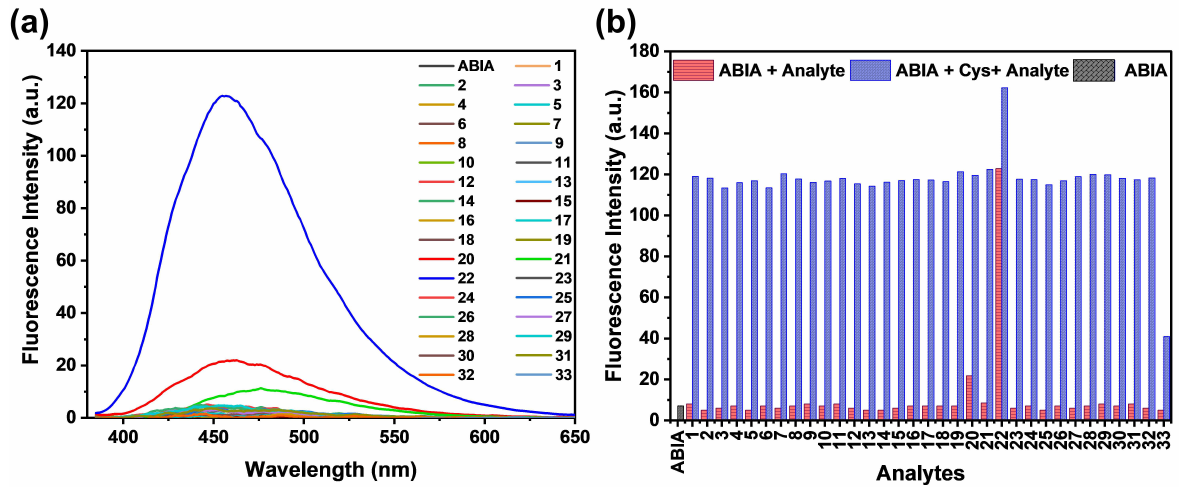
Figure 2. ( a ) Fluorescence spectra and ( b ) competitive study of ABIA (10 µ M, λ ex = 368 nm, λ em = 455 nm) in the absence and presence of five equivalents of various analytes (50 µ M). 1, Gly; 2, Ala; 3, Ser; 4, Pro; 5, Val; 6, Thr; 7, Ile; 8, Leu; 9, Asn; 10, Asp; 11, Gln; 12, Lys; 13, Glu; 14, Met; 15, His; 16, Phe; 17, Arg; 18, Tyr; 19, Typ; 20, Hcy; 21, Gsh; 22, Cys; 23, BSA; 24, Cl − ; 25, Br − ; 26, NO 3 − ; 27, AcO − ; 28, SO 42 − ; 29, PO 43 − ; 30, Na + ; 31, Cs + ; 32, Ca 2+ ; 33, Cu 2+